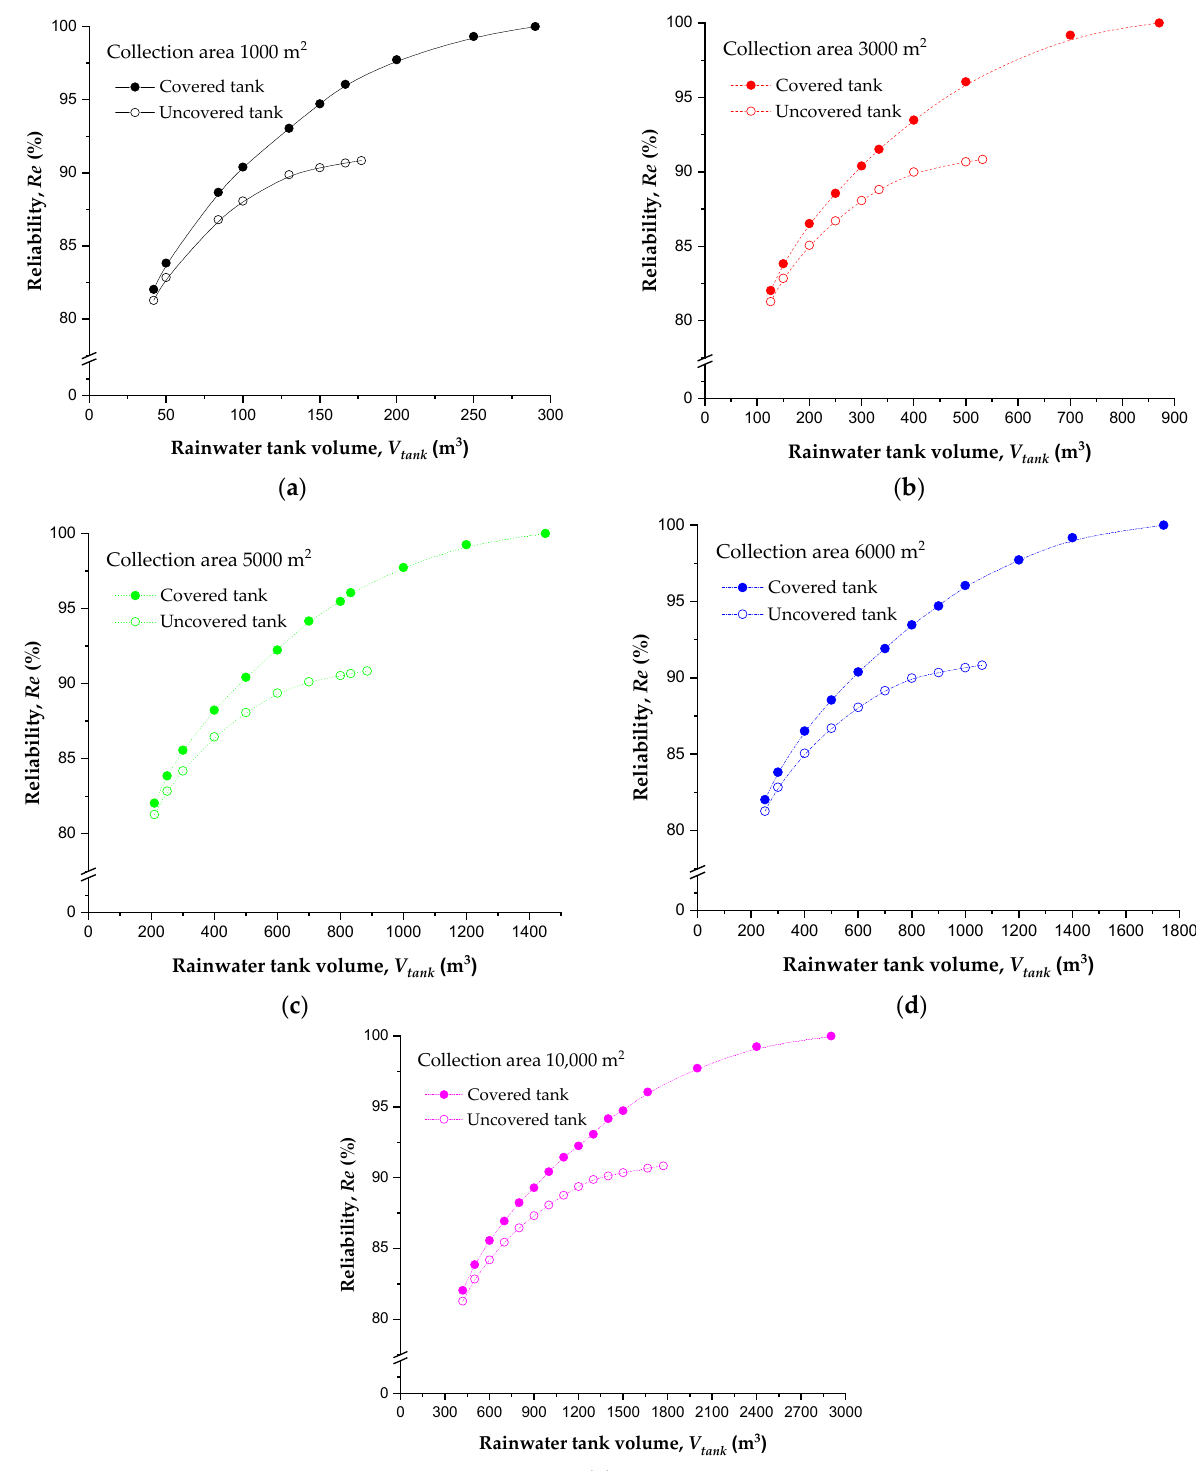
Figure 8. Comparative presentation of reliability curves in relation to tank sizes between covered and uncovered rainwater harvesting system to meet the demand of a tomato crop cultivated in greenhouses with rainwater collection areas: ( a ) 1000 m 2 ; ( b ) 3000 m 2 ; ( c ) 5000 m 2 ; ( d ) 6000 m 2 ; and ( e ) 10,000 m 2 .